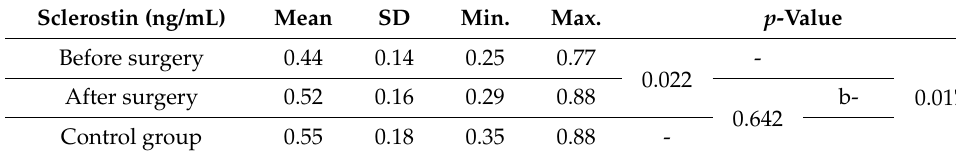
Table 6. Serum concentrations of sclerostin in study group vs. control group.